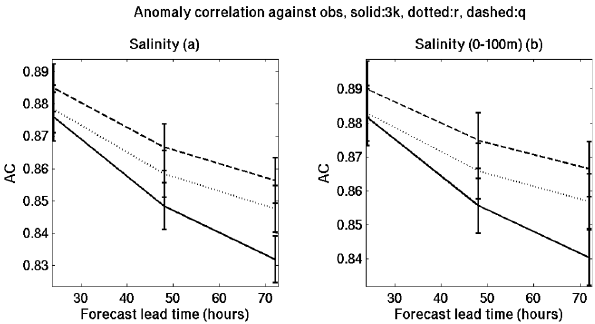
Fig. 8. The anomaly correlation of salinity for ensembles r (dotted), q (dashed) and ncom3km (solid) as functions of lead time. All AC values are averaged over the 109 days from 1 June to 17 September 2012, and averaged over the full observation space (a) , and the layer between 0 and 100m (b) . Error bars based on the standard error indicate the confidence